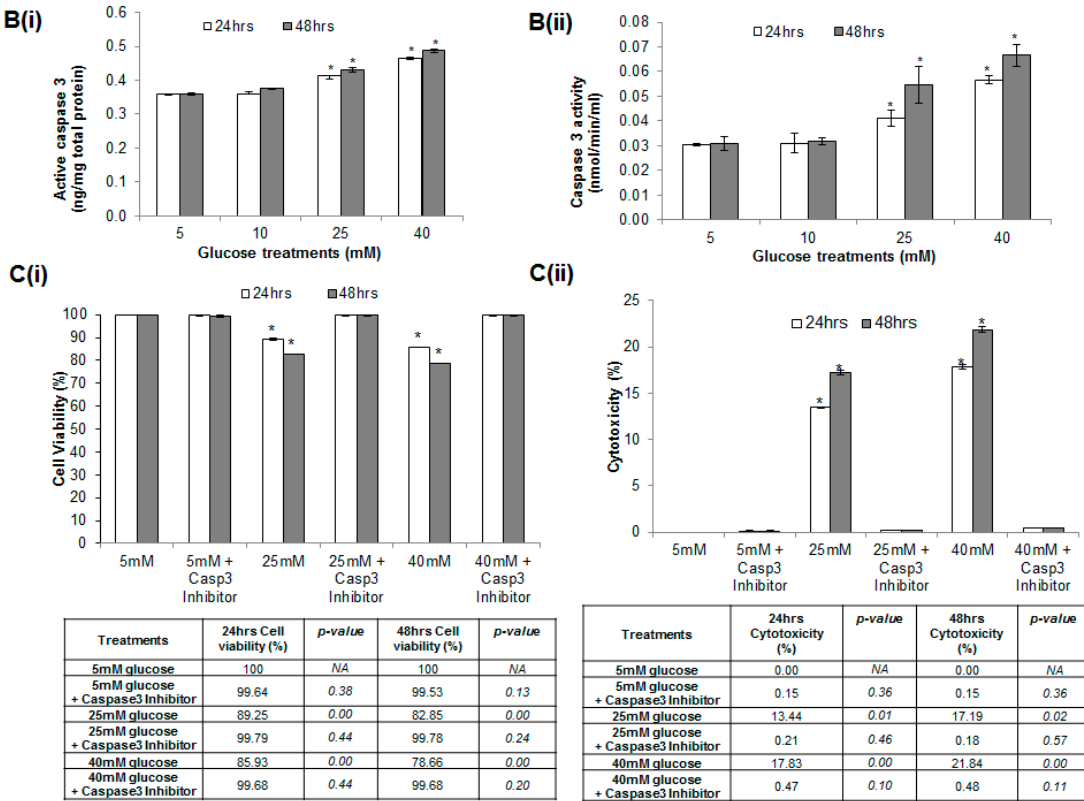
Figure 2. Endothelial cell apoptosis: ( A ) Representative data from 5, 25 and 40 mM glucose treatment at 24 and 48 h, ( i ) DAPI nuclear staining: The images were captured using Olympus IX51 microscope (20× magnification). Healthy nuclei can be observed for 5 mM glucose treatments (24 and 48 h). Condensed and pyknotic nuclei can be seen under hyperglycemic conditions at both 25 and 40 mM glucose treatment for 24 and 48 h, respectively (yellow arrowhead); ( ii ) Dot-plot graph on fluorescence-activated cell sorting (FACS) Annexin V staining. The percentage of healthy cells and apoptotic cells can be seen in R5 and R6 quadrants, respectively. Figure S3 (Supplementary Material) shows the histogram and statistical analysis computed for the DAPI stained unhealthy cells, Annexin V positive cells and Annexin V and Ethidium Homodimer III stained cells; ( B ) ( i ) Active Caspase 3 and ( ii ) Caspase 3 activity were measured by colorimetric readings and absorption of fluorescence released from the cleaved substrate (DEVD-AMC), respectively; ( C ) Cell viability ( i ) and cytotoxicity ( ii ) assay for HUVEC cells exposed to hyperglycemia in the presence of caspase 3 inhibitor. Table shows the significance t -test p -values for each treatment. All data presented as mean ± SEM ( n = 3); * Indicates statistical significance p < 0.05 using t -test (test vs. 5 mM Glucose treatment).